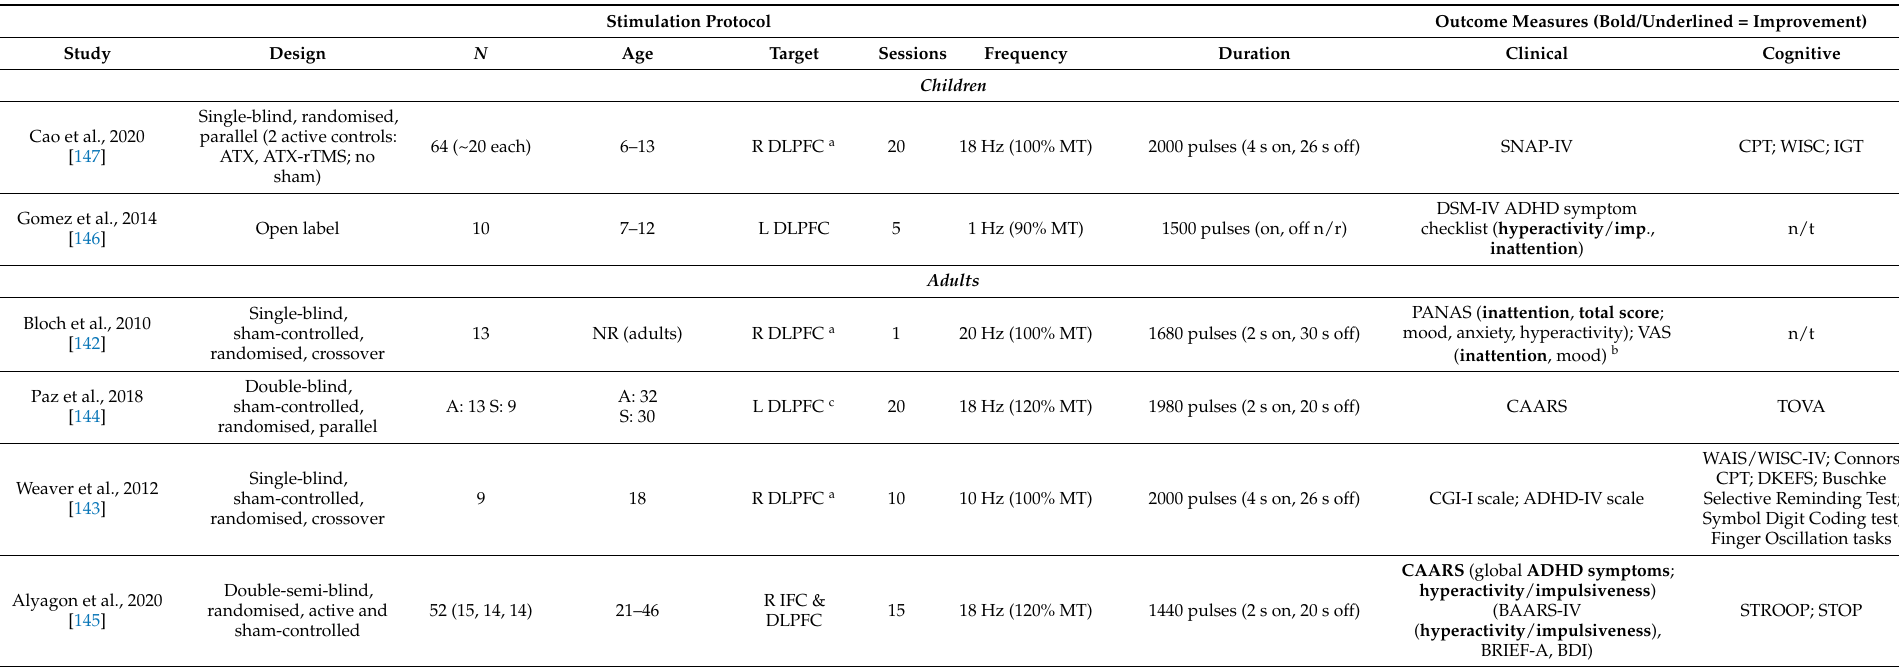
Table 1. Clinical and cognitive effects of sham-controlled rTMS